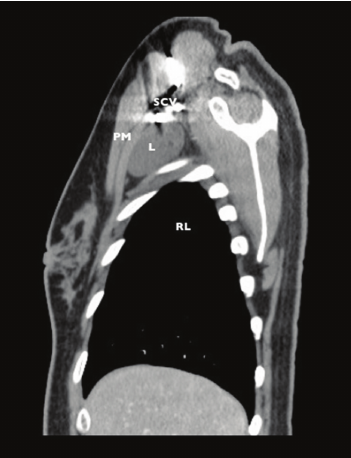
Figure 4: Color doppler ultrasound, axial view. PM: pectoral muscle; L: lymphocele; RL: right lung; SCV: subclavian